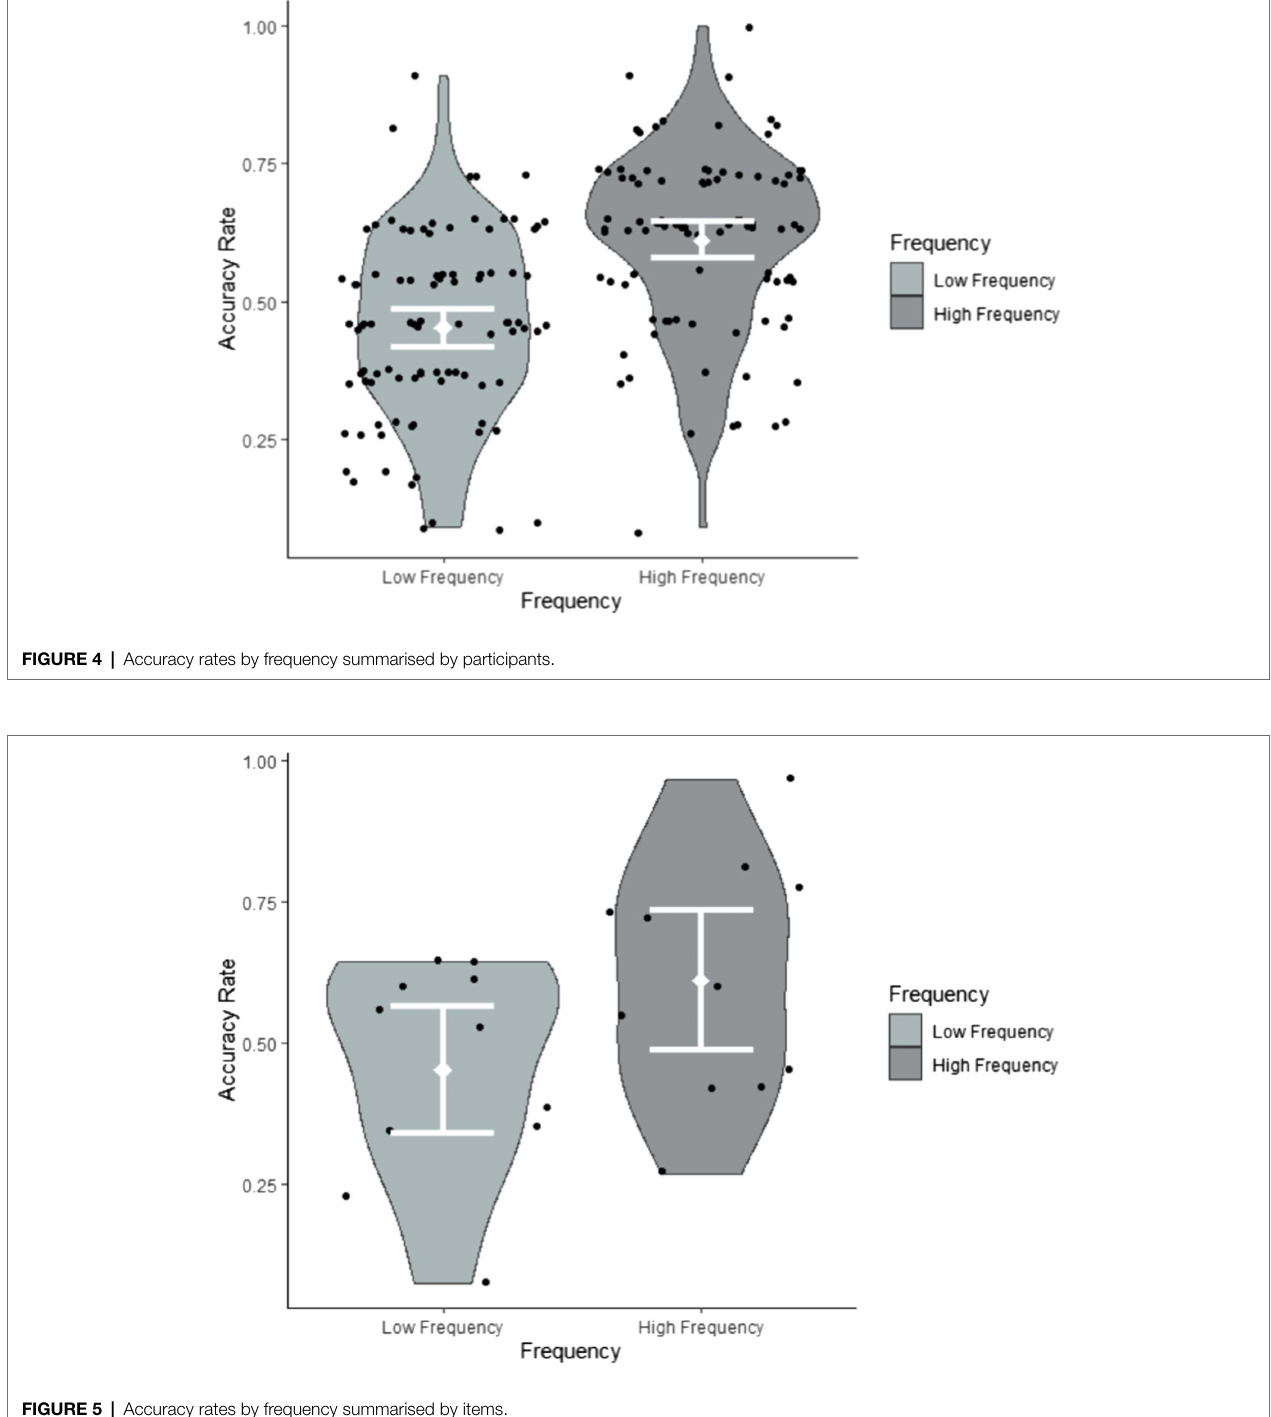
FIGURE 5 | Accuracy rates by frequency summarised by